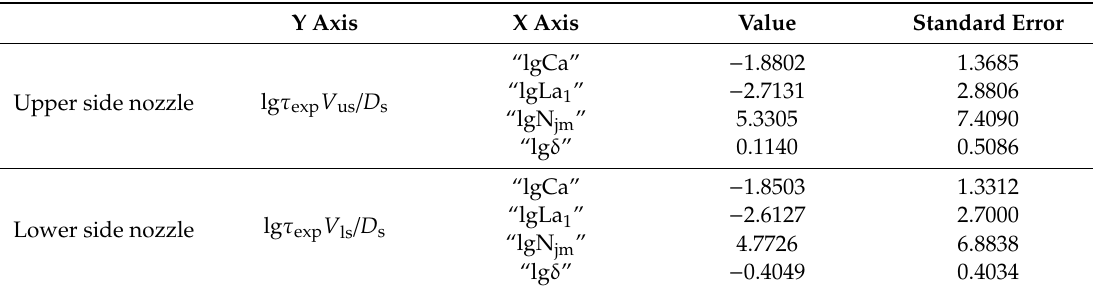
Table 8. Value and standard error of lg Ca, lg La 1 , lg N jm and lg δ by multiple linear regression for the upper side nozzle and lower side nozzle.